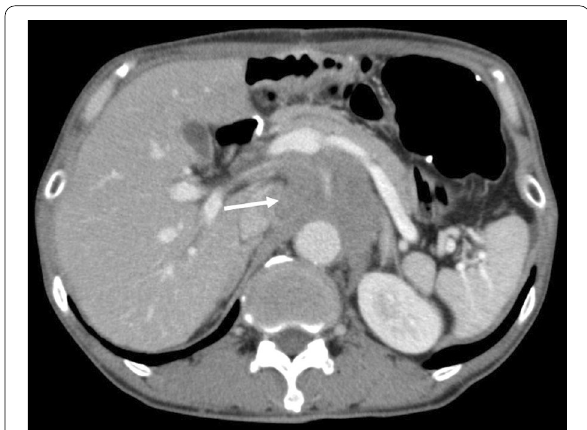
Fig. 3 After three courses of ramucirumab metastatic lymph node was 58 mm